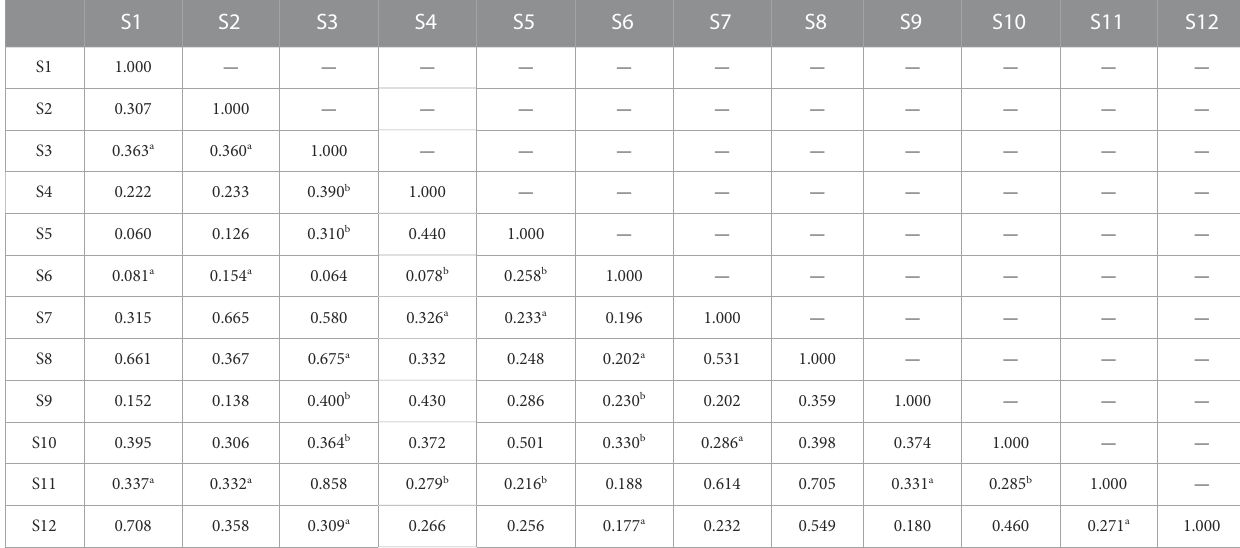
TABLE 5 Correlation matrix of the questionnaire